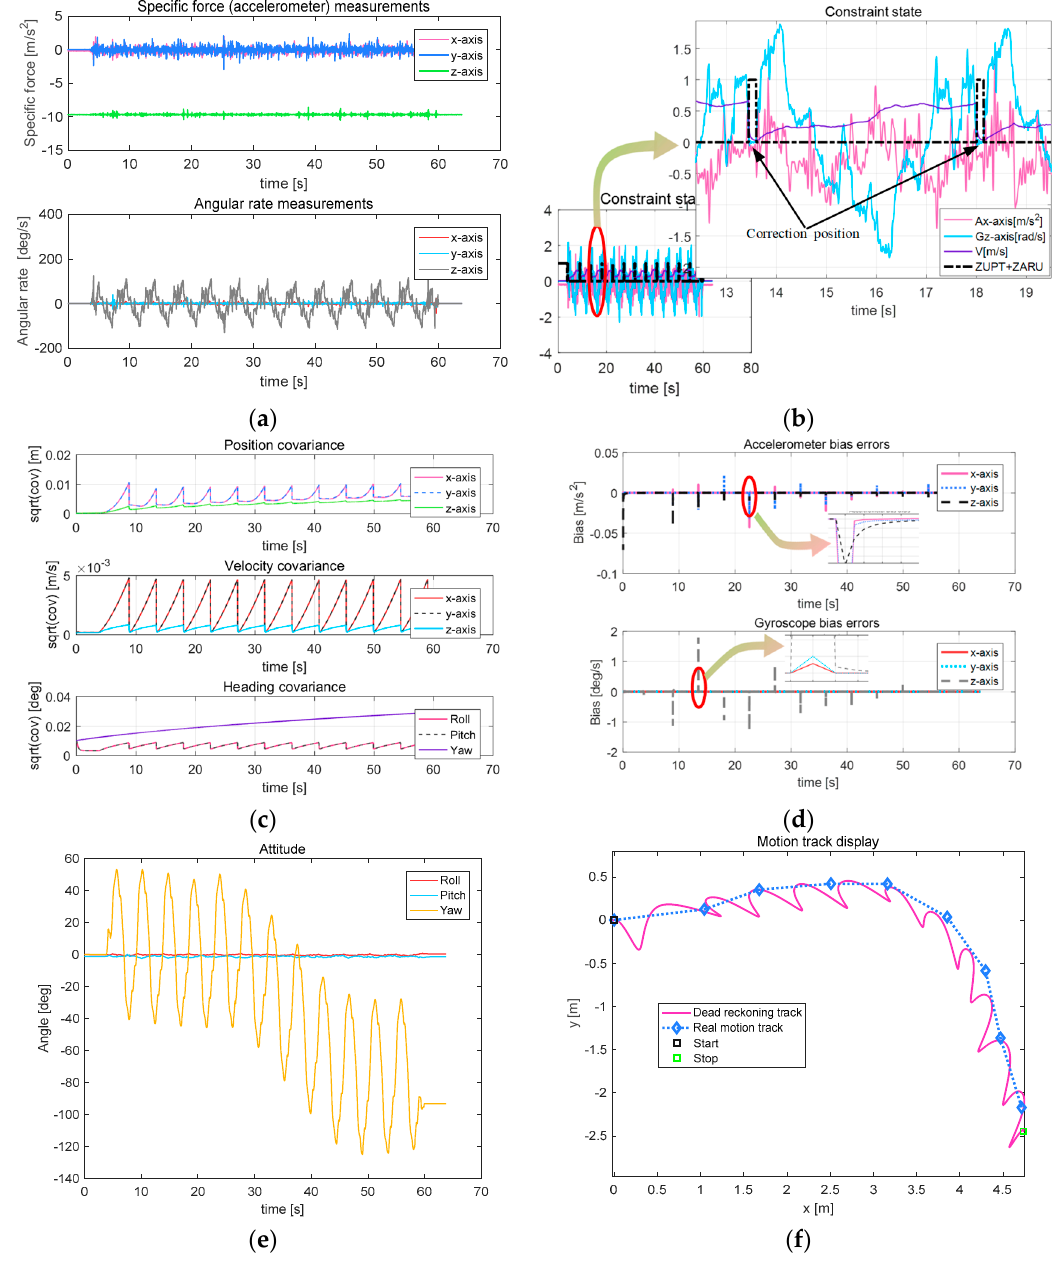
Figure 15. Parameters related to turn motion. ( a ) Output result of the MEMS IMU; ( b ) Constraint state; ( c ) Result of the covariance; ( d ) Bias errors; ( e ) Attitude of the snake robot; ( f ) Moving path of the snake robot.